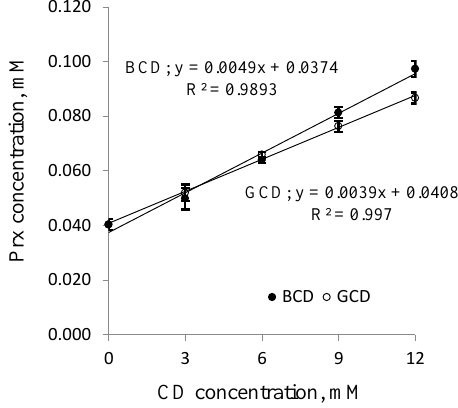
γ -CD (GCD). (cid:35)